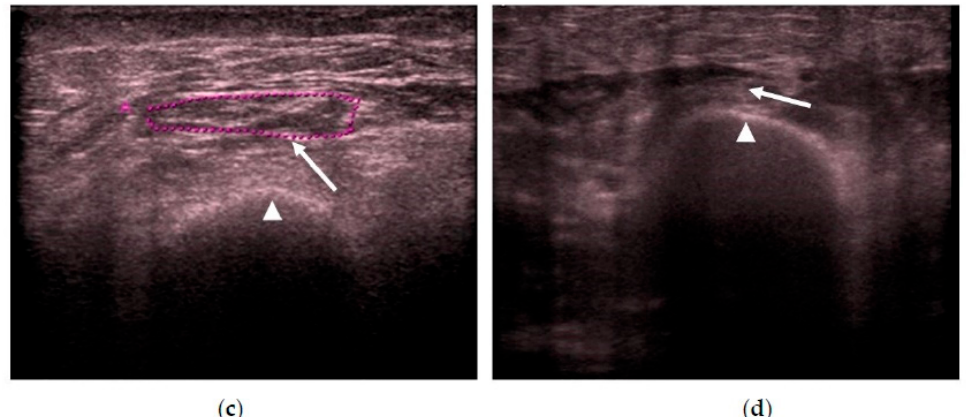
Figure 1. Transversal ultrasonography (US) scan that shows quadriceps rectus femoris (QRF) muscle echogenicity. ( a ) Matched healthy control: Category 1 (normal hypoechogenicity), with the central tendon (thick arrow). ( b ) Category 2 (heterogeneous). ( c ) Category 3 (fat infiltration). ( d ) Category 4 (atrophy due to fasciitis and muscle necrosis). QRF: quadriceps rectus femoris (arrows); femur (arrowhead); ST: subcutaneous cellular tissue (dotted line); US: ultrasound. We measured the CSA in cm 2 and muscle thickness in mm, and scanned for the presence or absence of edema in the subcutaneous cellular tissue and the intramuscular and intrafascial fluid (Figure 2).